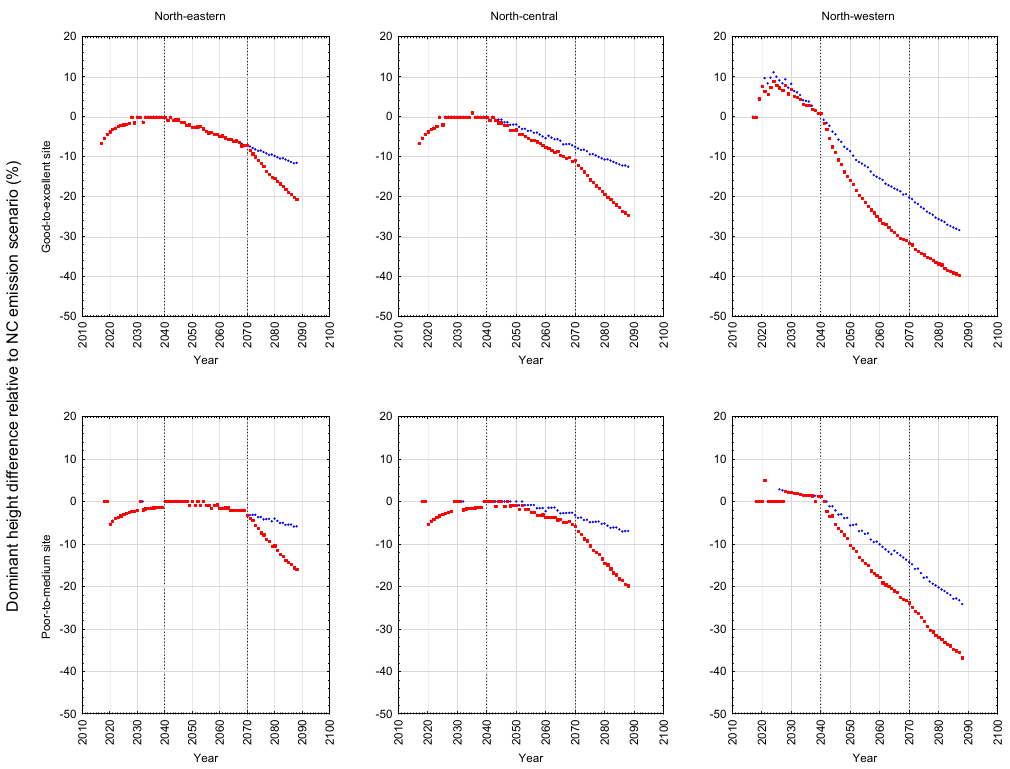
Figure 6. Dominant height developmental differences for jack pine plantations relative to the NC emission scenario (%) for the B1 (circle) and A2 (square) emission scenarios by site quality and locale. The vertical dotted lines denote termination of the first and second commitment periods (2040 and 2070, respectively).